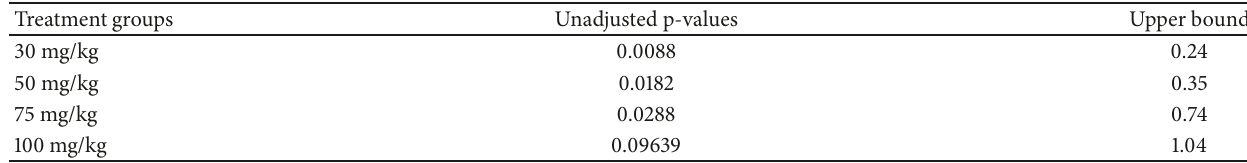
Table 4: Summary of the test for micronucleus assay data from Hasler et al.